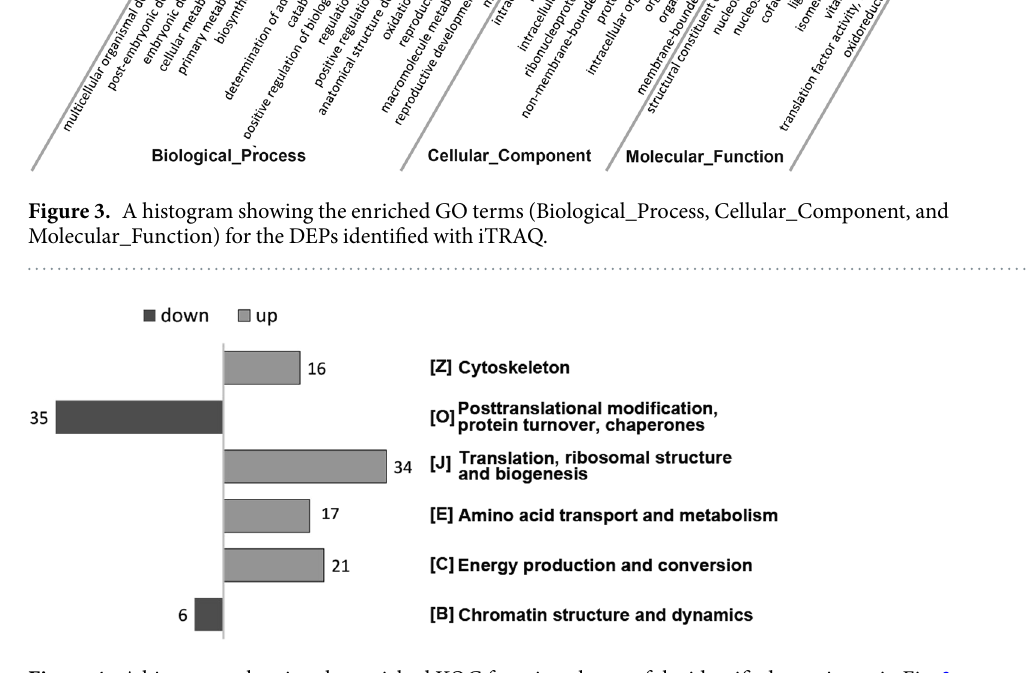
Figure 4. A histogram showing the enriched KOG function classes of the identified proteins as in Fig.